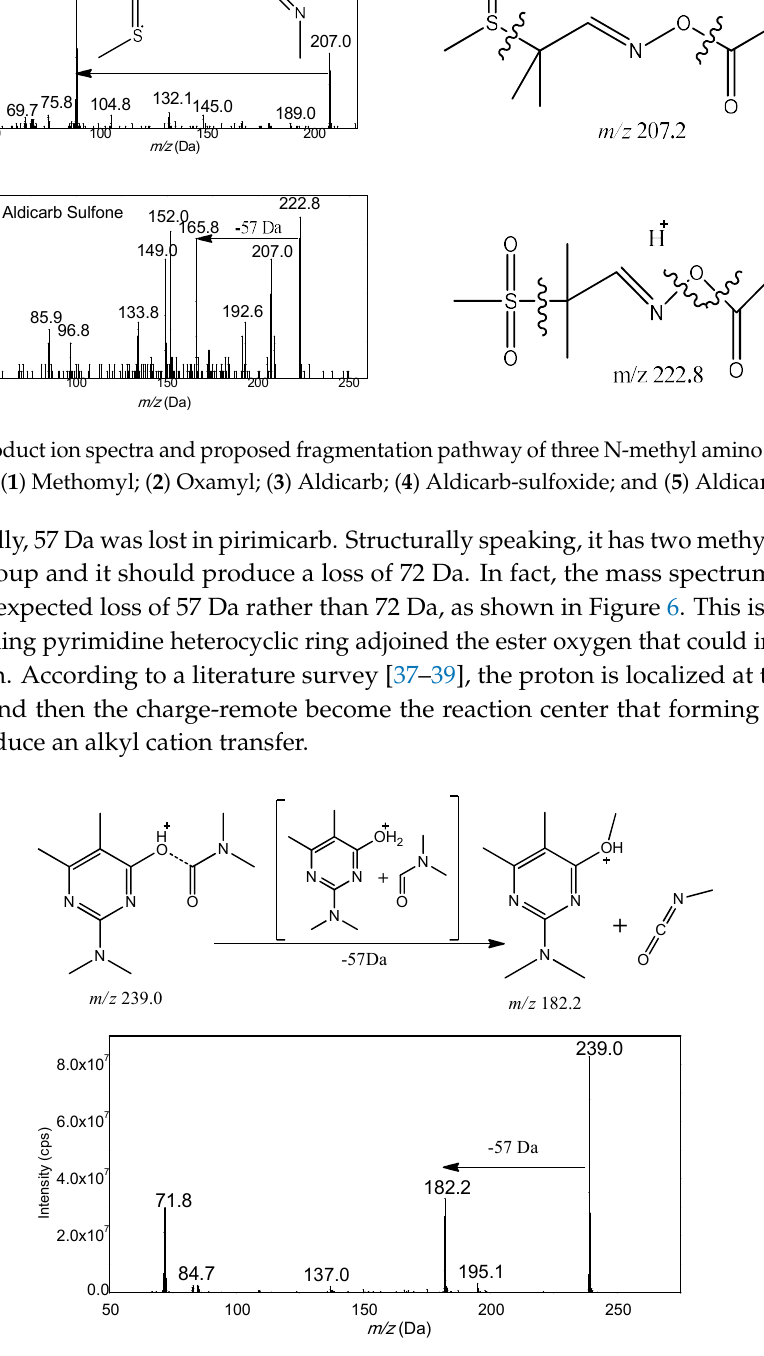
Figure 6. Product ion spectra and probable fragmentation routes of Pirimicarb.